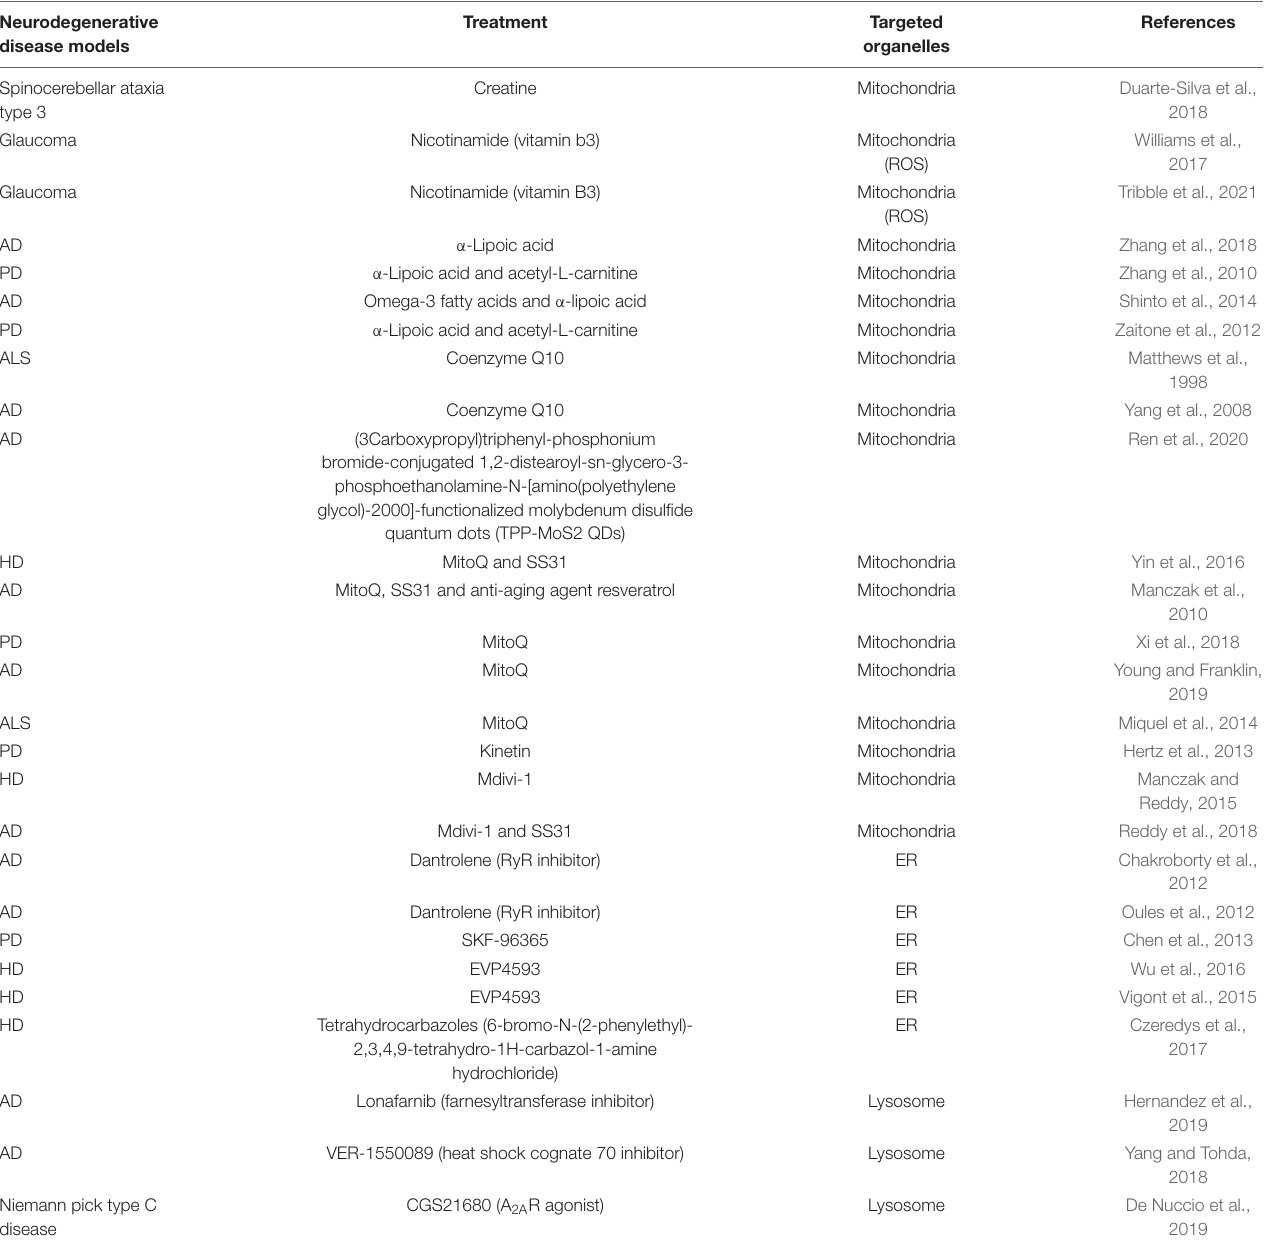
TABLE 1 | The compounds reported to be functional in models of neurodegenerative diseases targeting different